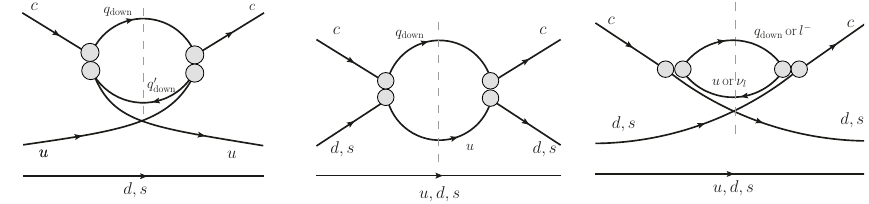
Figure 3. Diagrammatic representations of the spectator contributions resulting in the four-quark operators in baryons . From left to right: (a) destructive Pauli interference, labelled ‘int − ’; (b) Weak exchange, labelled ‘exc’; (c) constructive Pauli interference, labelled ‘int + ’. The non-participating light quark is also indicated. The correspondence to the equivalent meson diagrams is clearly visible by comparison with figure 2.